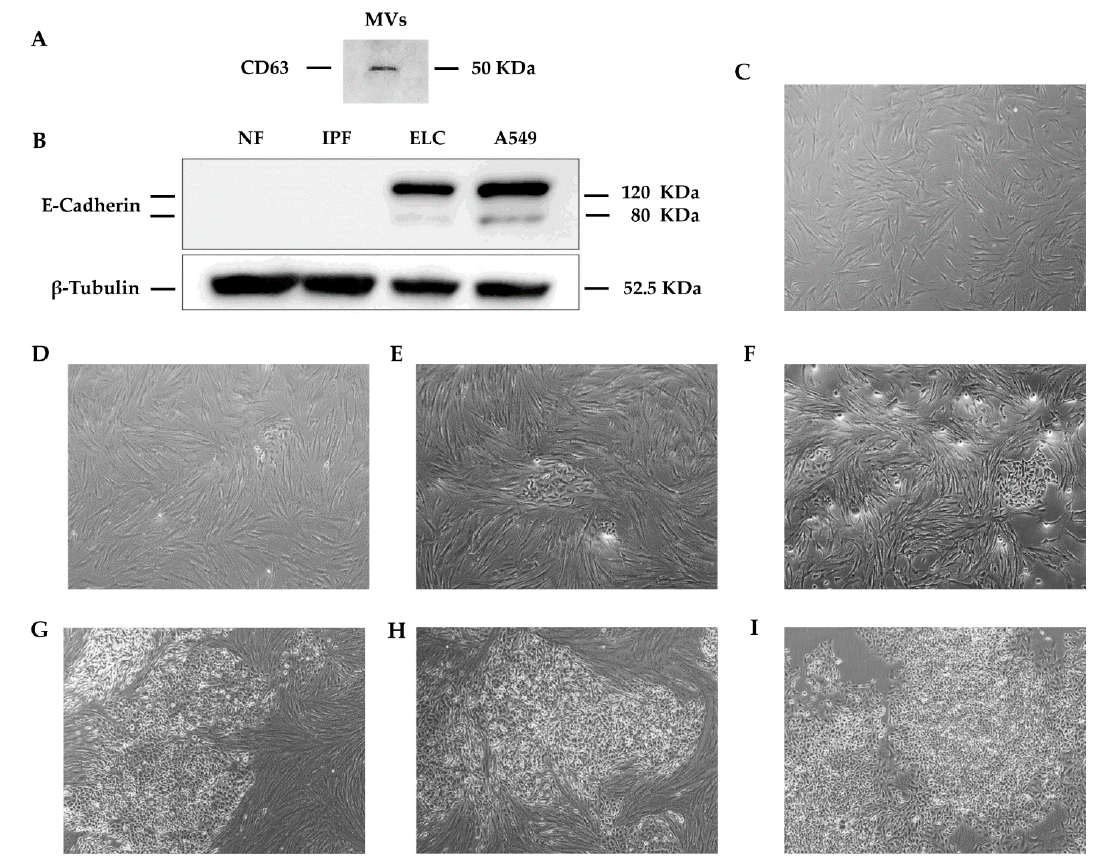
Figure 8. Microvesicles (MVs) obtained from ELC induce the change to an epithelial-like phenotype in human normal lung fibroblasts. Representative immunoblot image to the CD63 protein in MVs purified from ECL from an IPF patient ( A ). MVs effect on E-cadherin expression analyzed by Western blotting: MVs purified from culture media obtained from human normal lung fibroblasts (NF; passage 4), IPF fibroblasts (IPF; passage 4), and ELC (passage 4). Total protein extract from A549 epithelial cell line was used as a positive control ( B ). Serial images of human lung fibroblasts incubated with MVs converted in ELC, observed with phase-contrast microscopy (original magnification ×10): area with 100% of normal lung fibroblasts ( C ). Image captured after 2 days exhibiting ~95% fibroblasts and ~5% ELC displaying a polygonal/cobblestone shaped, closely connected to each other and focally accumulated appearance ( D ). Image obtained after 4 days exhibiting ~90% fibroblasts and ~10% of ELC ( E ). Image acquired after 6 days showing ~65% fibroblasts and ~35% of ELC ( F ). Image taken after 8 days displaying ~40% fibroblasts and ~60% of ELC ( G ). Image obtained after 10 days displaying ~20% fibroblasts and ~80% ELC ( H ). Area covered at ~100% by ELC captured after 12 days of culture, where fibroblasts are not apparent ( I